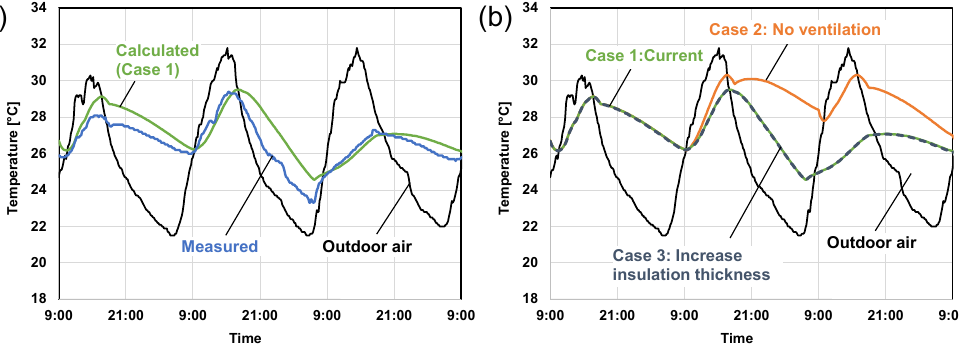
Figure 14. ( a ) Measured and calculated (Case 1) indoor temperature on the first floor, and ( b ) calculated indoor temperature in each case.